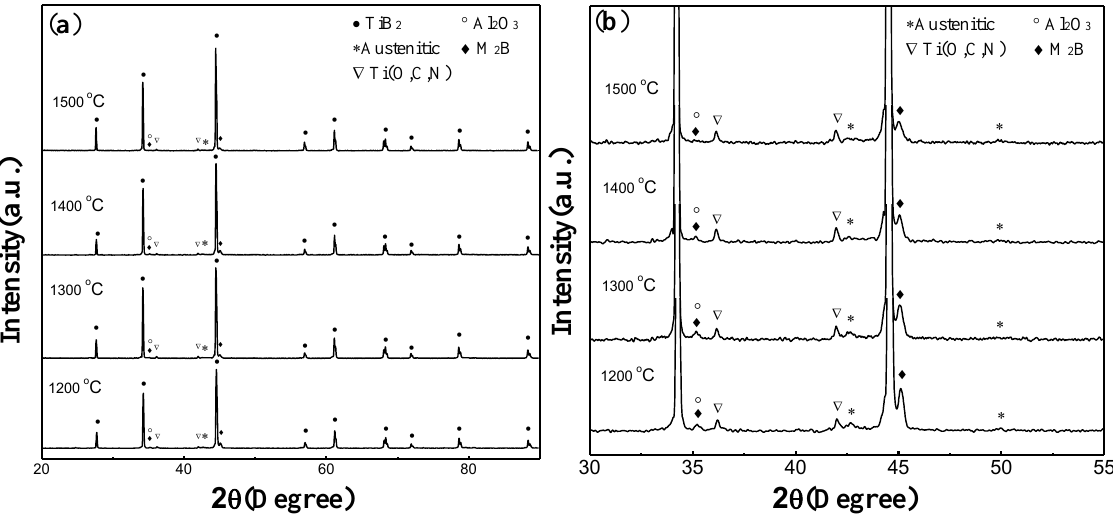
Figure 4. XRD (X-ray diffraction) patterns obtained from the polished surface of TiB 2 –5 wt% (Fe–Ni–Ti–Al) composites sintered at different temperatures: ( a ) full extent and ( b ) selected region.